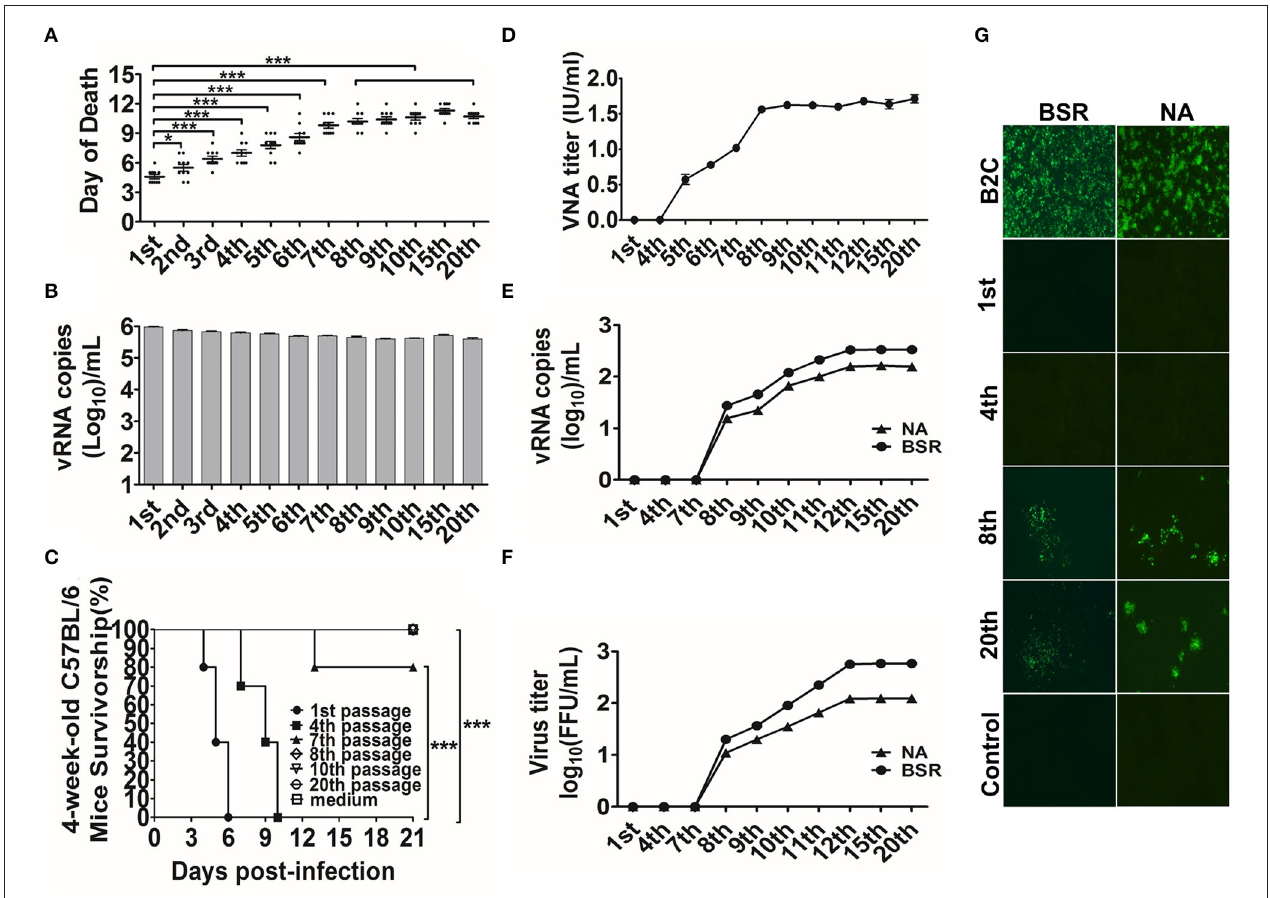
FIGURE 1 | CNIM1701 was adapted to culture cells after 20 passages in the suckling mice. (A) Survivorship of 1-day-old C57 BL/6 mice intracranially inoculated with CNIM1701 for 20 passages. Each group contained 10 mice, and all mice were euthanized after rabies clinical sign. (B) The genomic RNA of each passage RABV was detected by qRT-PCR. (C) Survivorship of 6-week-old C57 BL/6 mice infected with the indicated RABV through IM inoculation. (D) VNAs in mice were infected with each passage of RABV. (E) The viral genomic RNA of different generations of CNIM1701 was detected in BSR or NA cells by qRT-PCR after 48h infection. (F) The virus titer of different generations of CNIM1701 was detected in BSR or NA cells with FITC-labeled anti-rabies virus N protein antibody after 48h infection. (G) BSR and NA cells were infected with each passage CNIM1701 for 48h and stained using FITC-labeled anti-rabies virus N protein antibody at 200 × magnification. Statistical analysis of group differences was performed using unpaired t -test or log-rank test. A value of * p < 0.05, ** p < 0.01, or *** p < 0.001 was considered statistically